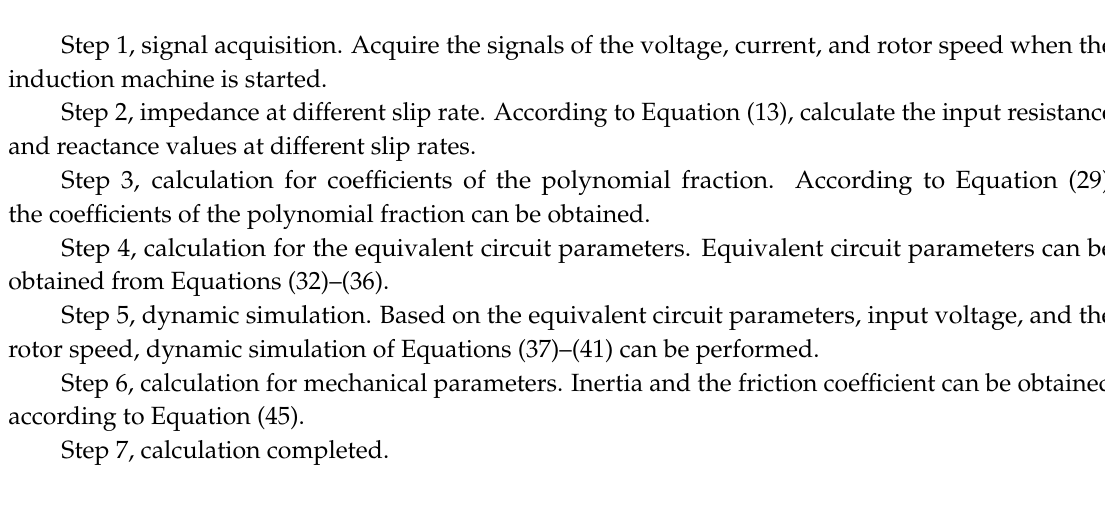
Figure 3. Flowchart of procedure.